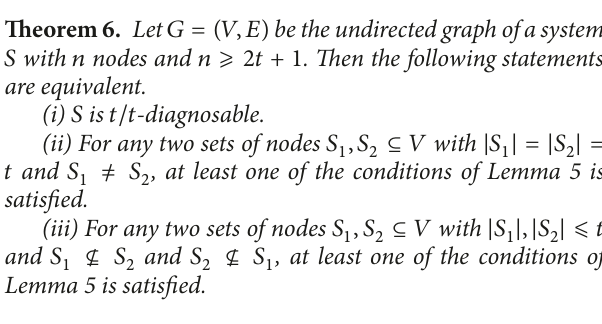
Figure 2: The Venn diagram of graph